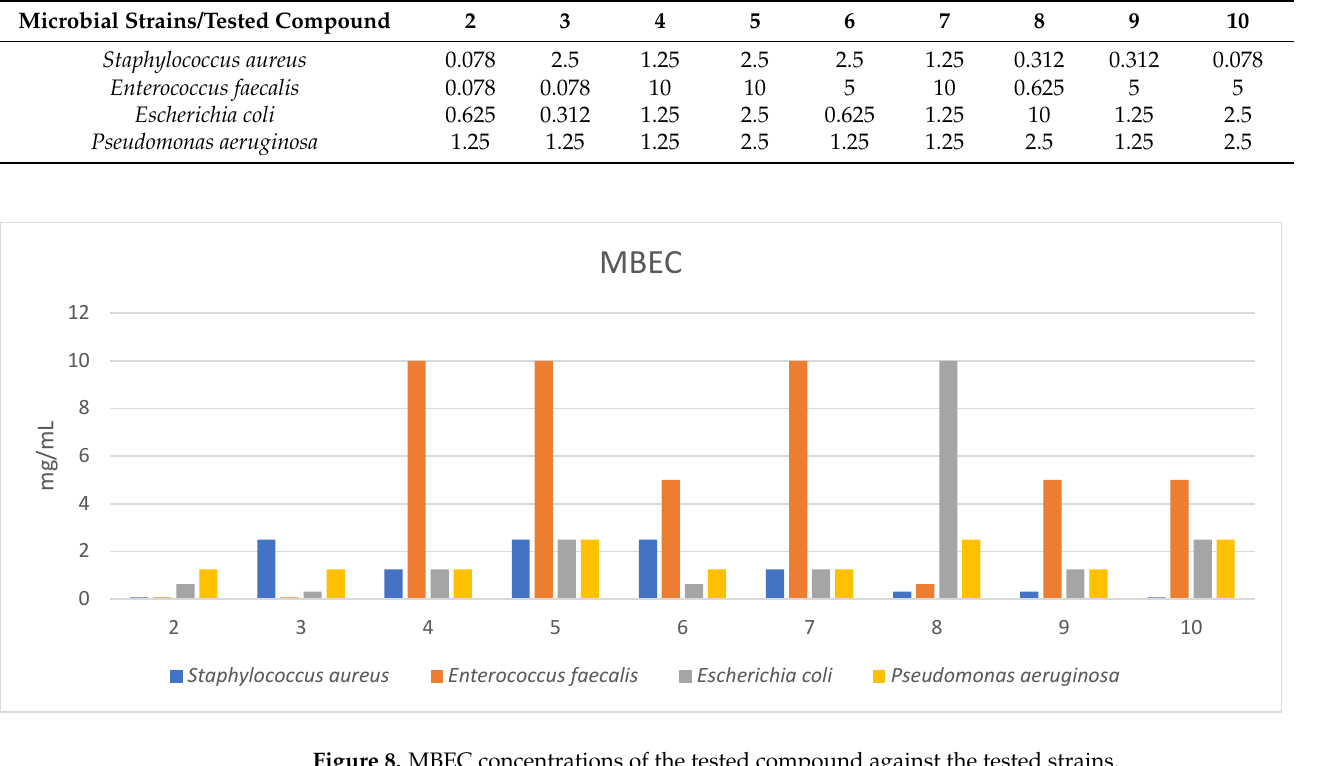
Figure 8. MBEC concentrations of the tested compound against the tested strains.